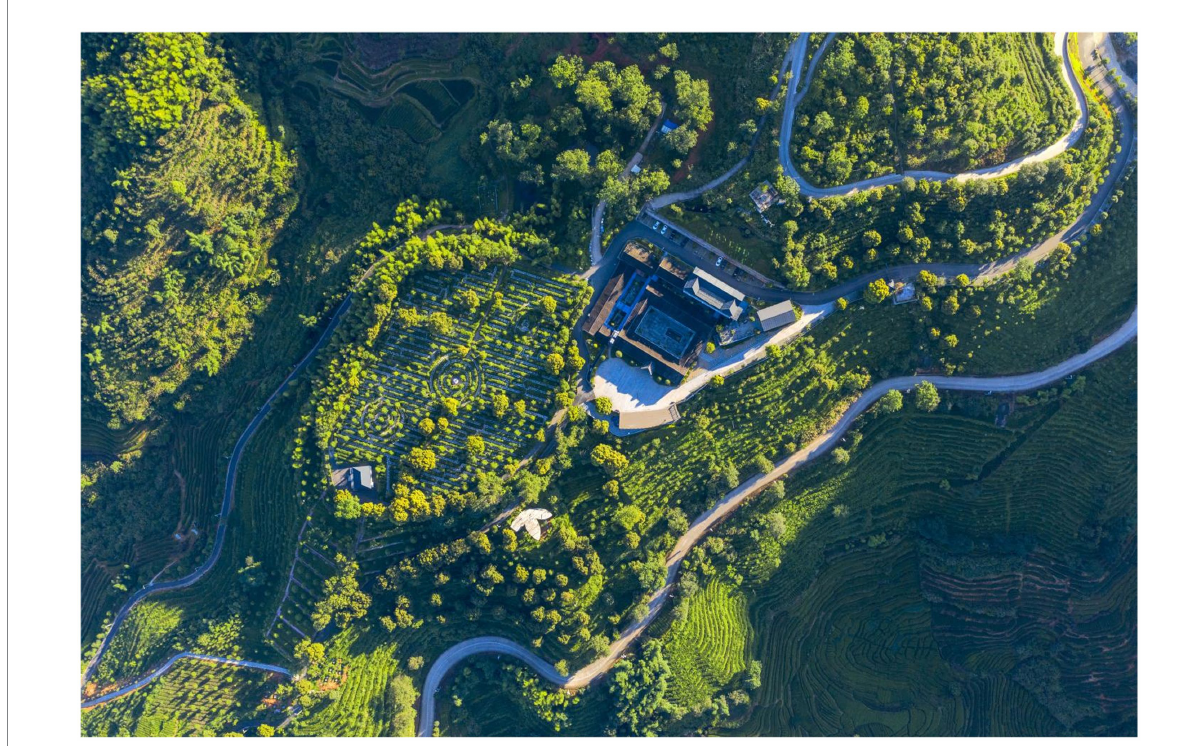
FIGURE 2 Anxi Yunling Tea Estate. Adapted/Reproduced with permission from Anxi Yunling Tea Estate, available at: https://commons.wikimedia.org/wiki/ File:Anxi_Yunling_Tea_Estate.jpg.